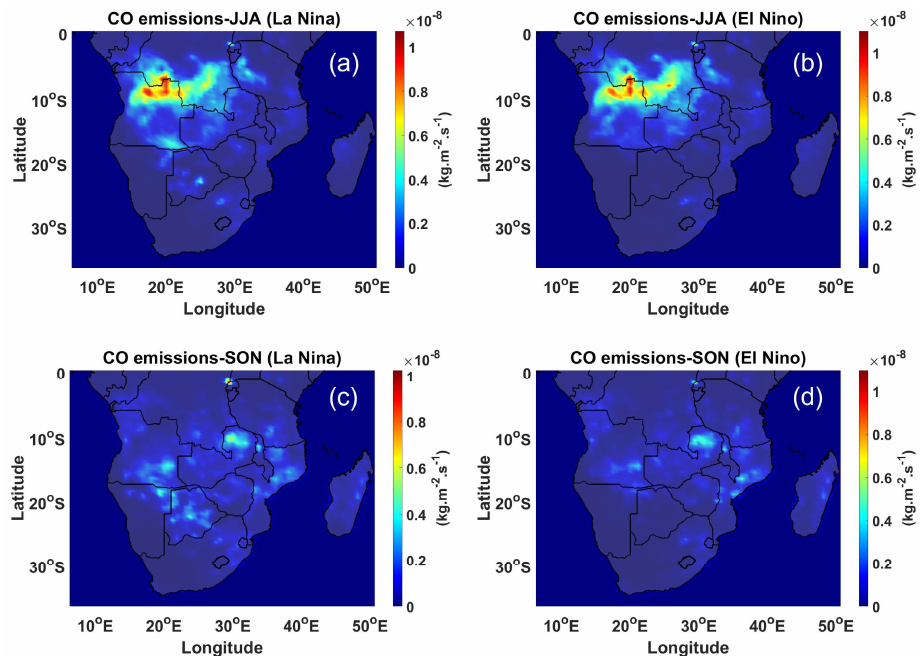
Figure 7. Spatial distribution of CO emissions for the JJA ( a , b ) and SON ( c , d ) seasons during the La Niña ( a , c ) and El Niño ( b , d ) events.